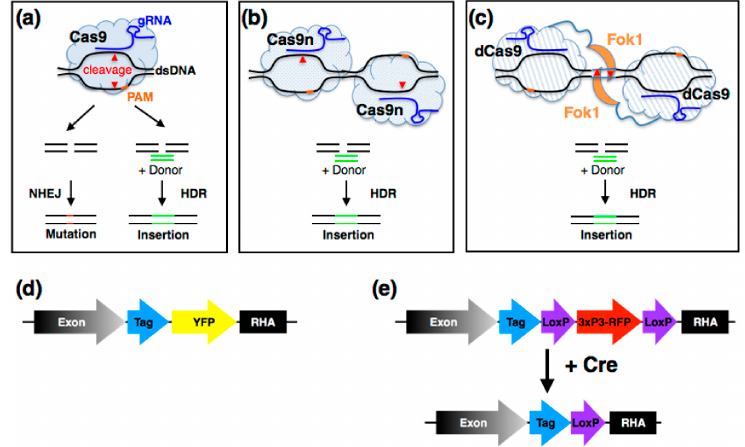
Figure 3. CRISPR Genome Engineering. ( a ) The wild-type Cas9 complex (light blue cloud) contains the Cas9 endonuclease and a guide RNA (gRNA) (blue) complementary to the target site adjacent to a PAM sequence (orange). The complex opens the DNA duplex and introduces a double strand break (red triangles). Repair by the non-homologous end joining (NHEJ) pathway may result in indel mutations whereas homology directed repair (HDR) in the presences of a donor template (green) generates insertions. ( b ) Using mutant Cas9n enzymes that make single strand cuts with two gRNAs (blue) direct the Cas9n complexes to make cuts (red triangles) separated by some distance. The gap may be repaired in the presence of a donor (green) to generate an insertion. ( c ) Dead Cas9 (dCas9) enzymes (which are unable to cleave DNA) are fused with FokI nuclease monomers (orange). When two gRNAs (blue) some distance apart are used, dCas9-FolkI monomers are brought into proximity allowing the FokI to dimerise and cleave in between. The resulting gap may be repaired in the presence of a donor (green) to generate an insertion. ( d ) Diagram of donor cassette for direct addition of a protein tag to the C-terminal of a coding exon. The donor DNA contains part of the exon sequence with a biochemistry tag and yellow fluorescent protein (YFP) in frame, followed by a right hand end homology arm (RHA) that can mediate the type of insertion event shown in ( a ). ( e ) Diagram of a donor sequence used to introduce biochemistry tags to the C-terminal of a coding exon along with a removable marker. The donor DNA contains part of the exon sequence with a biochemistry tag in frame. This is followed by an eye expressed red fluorescent protein (RFP) cassette flanked by LoxP sites, which are downstream of the splice donor site and thus within an intron, then a right hand homology arm. Once a verified insertion has been recovered, tracked by the acquisition of RFP, the RFP is removed by exposing to Cre recombinase and recovering flies who have lost RFP expression. The resulting lines have the tagged exon and a single intronic LoxP